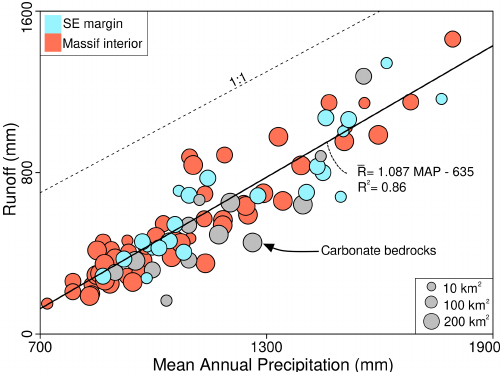
Figure 4. Comparison between runoff and mean annual precipita- tion for 83 selected gauging stations and their corresponding water- sheds. Blue and orange symbols correspond to watersheds located on the southeastern margin and inside the Massif Central, respec- tively. Grey circles indicate basins draining carbonate bedrock. The size of the circles depends on the area of the watersheds. The black dashed line corresponds to MAP = R , and the black solid line is a linear fit excluding carbonate bedrock